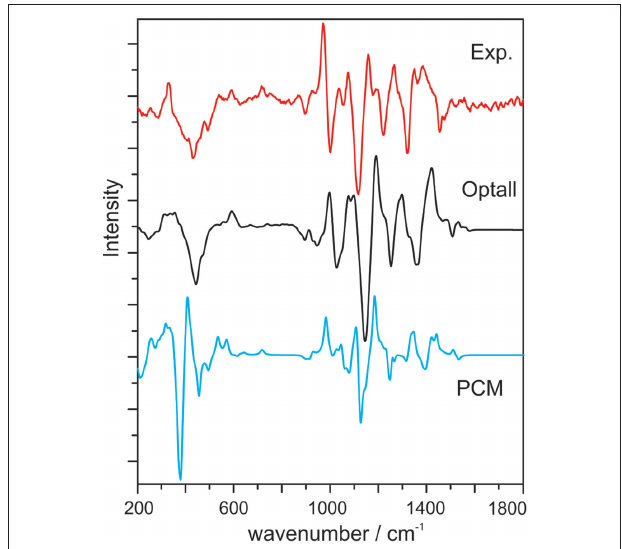
FIGURE 13 | Experimental ROA spectrum of methyl- β -D-glucose, calculated ROA spectrum with the optall process (see text for details), and calculated ROA spectrum using PCM. All calculated spectra are 60:40 weighted averages of the gg and gt conformers of methyl- β -D-glucose. Reproduced with permission from Cheeseman et al. (2011). Copyright 2011, American Chemical